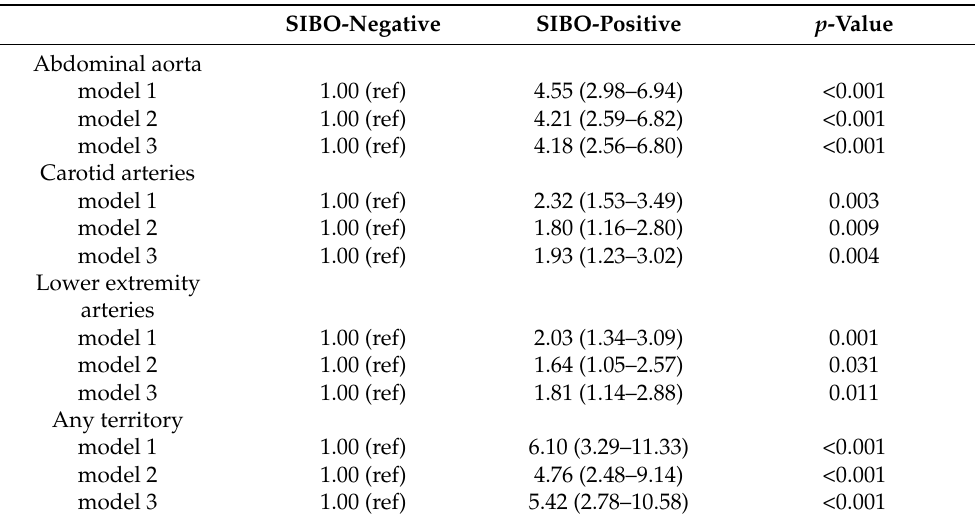
Table 3. Odds ratios (95% CIs) for plaque presence in different territories of the SIBO-positive and SIBO-negative